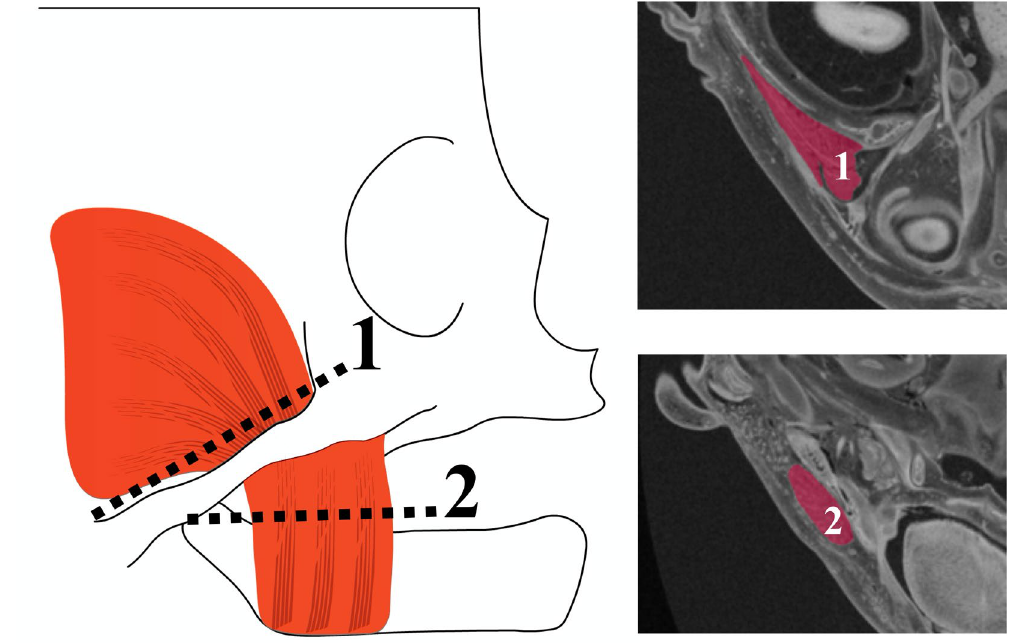
Figure 1. Measurement of muscle cross-sectional areas. The cross-sectional area (CSA) of the temporalis and masseter muscles were measured from MRI slices obtained at the level of a plane placed parallel and just superior to the zygomatic arch (1) and a plane parallel to the mandibular plane (2),